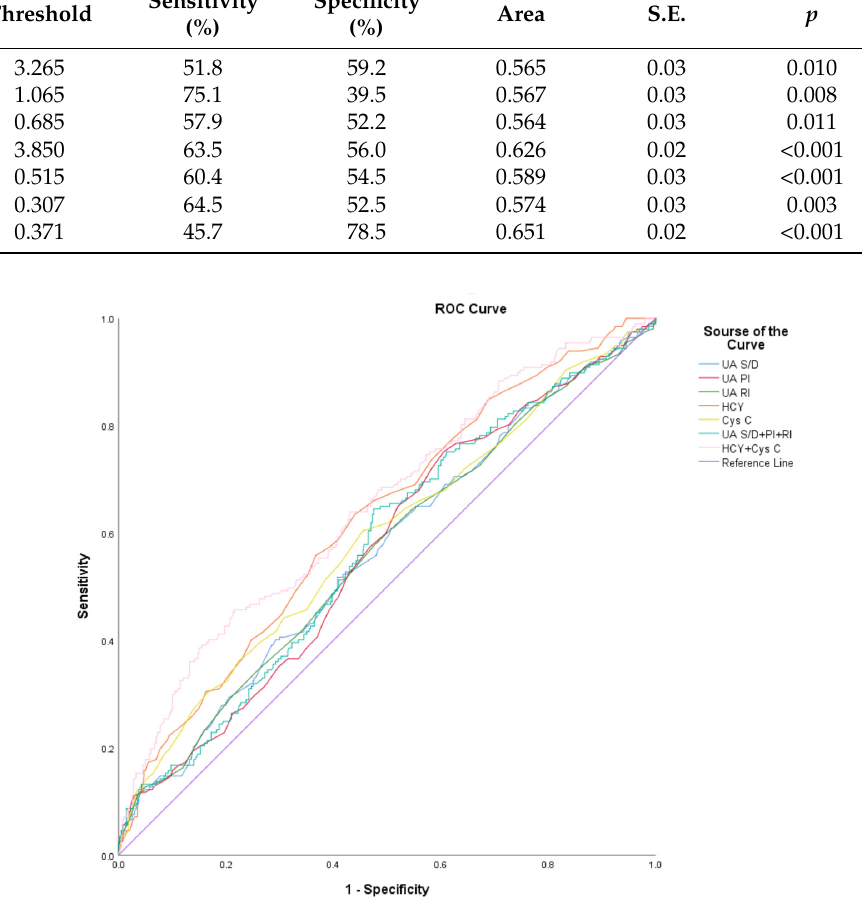
Figure 1. ROC Curve. Table 9. The area under the